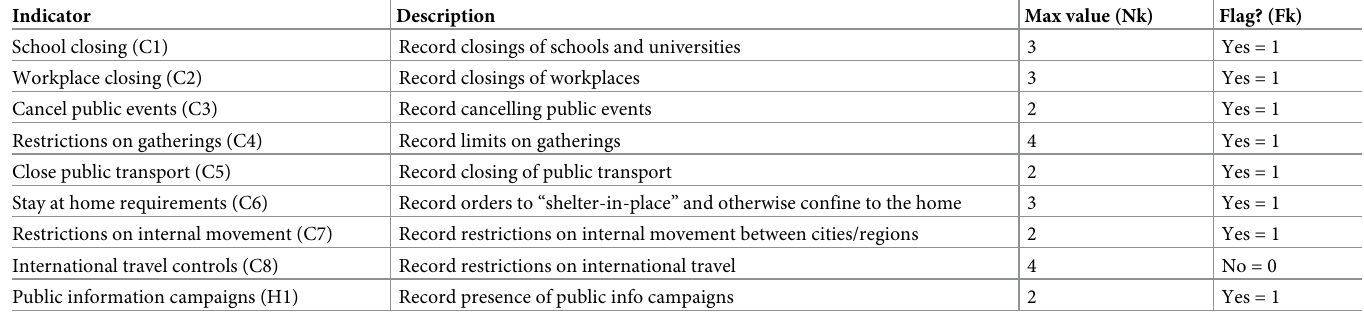
Table 3. List of indicators included in the computation of Stringency Index (SI). Each value encodes to a specific set of measures applied concerning the indicators. The Flag column indicates whether the policy has a variable that defines the geography of its application (1) or not